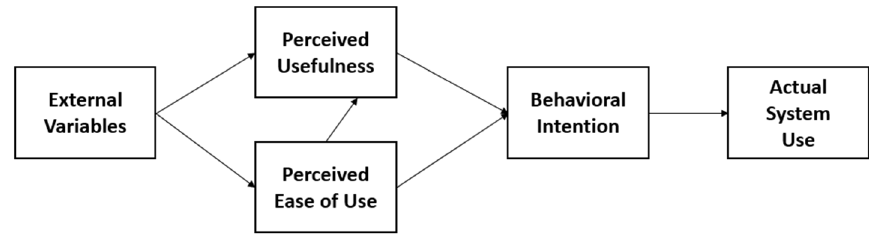
Figure 1. Technology acceptance model [28].